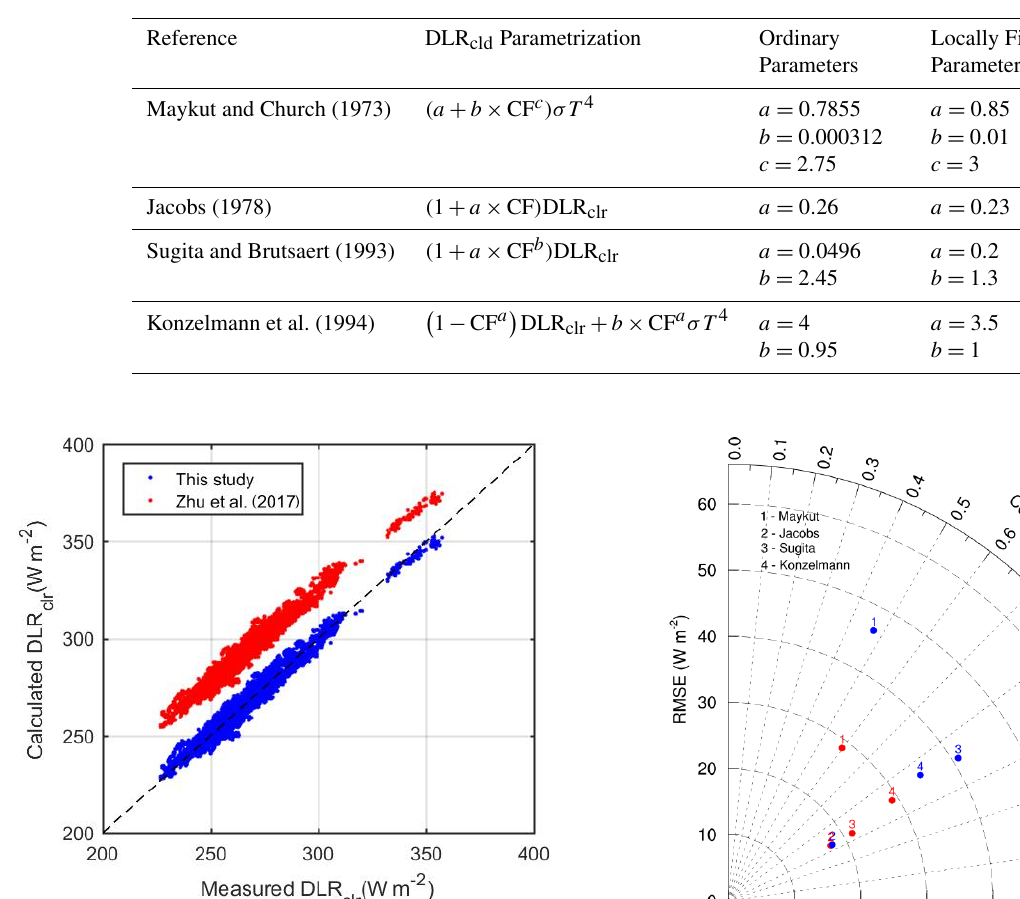
Table 4. 4 Ordinary and locally fitted cloudy-sky DLR parametrizations.